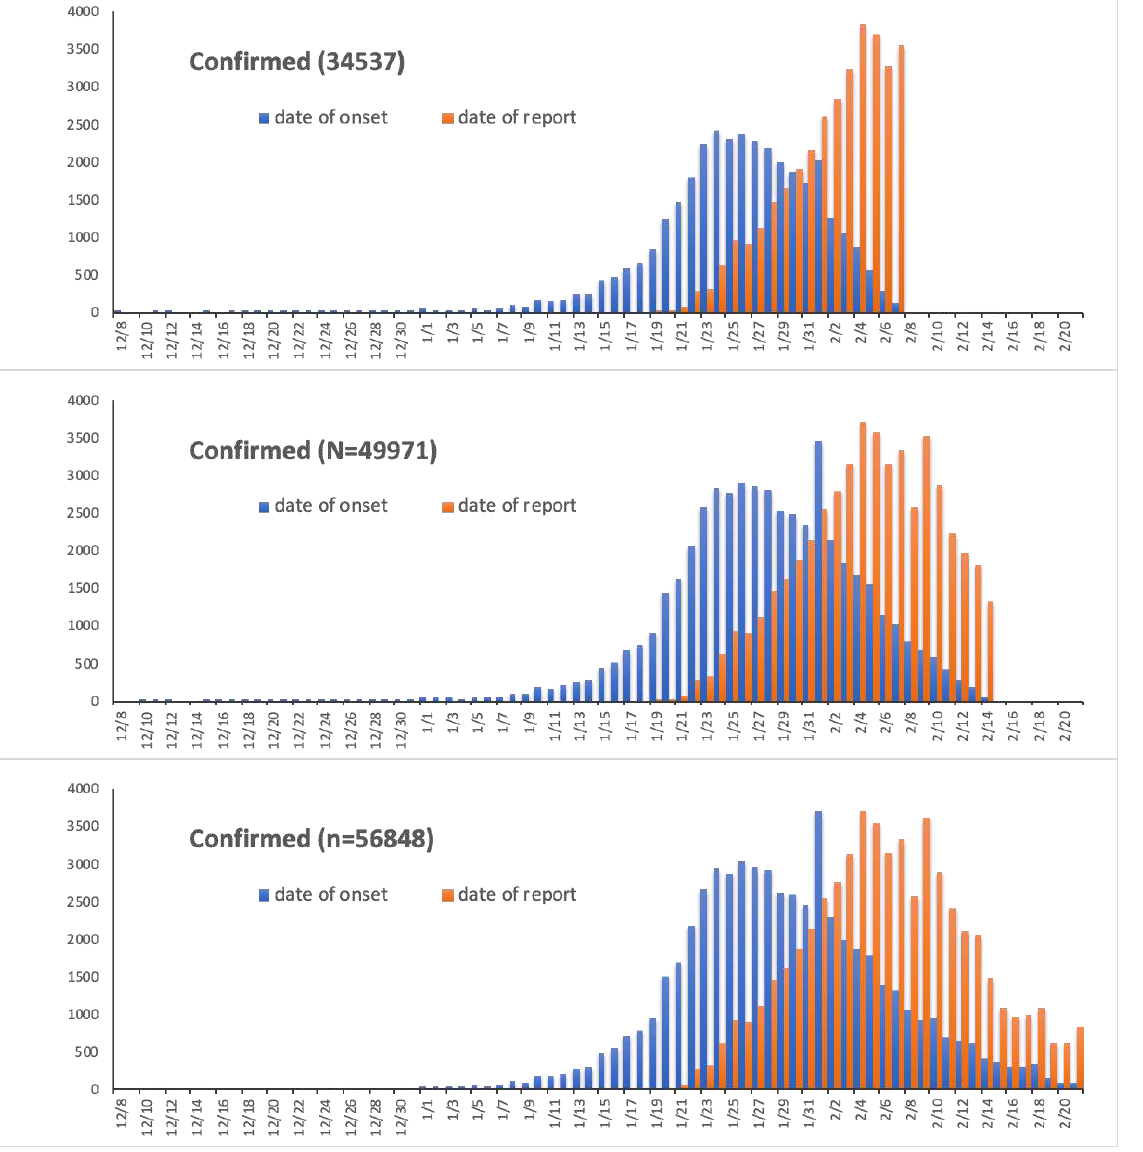
Figure 3. Epidemic curves by symptom onset and date of report as of 5 February (top panel), 12 February (middle panel) and 20 February 2020 (lower panel) for